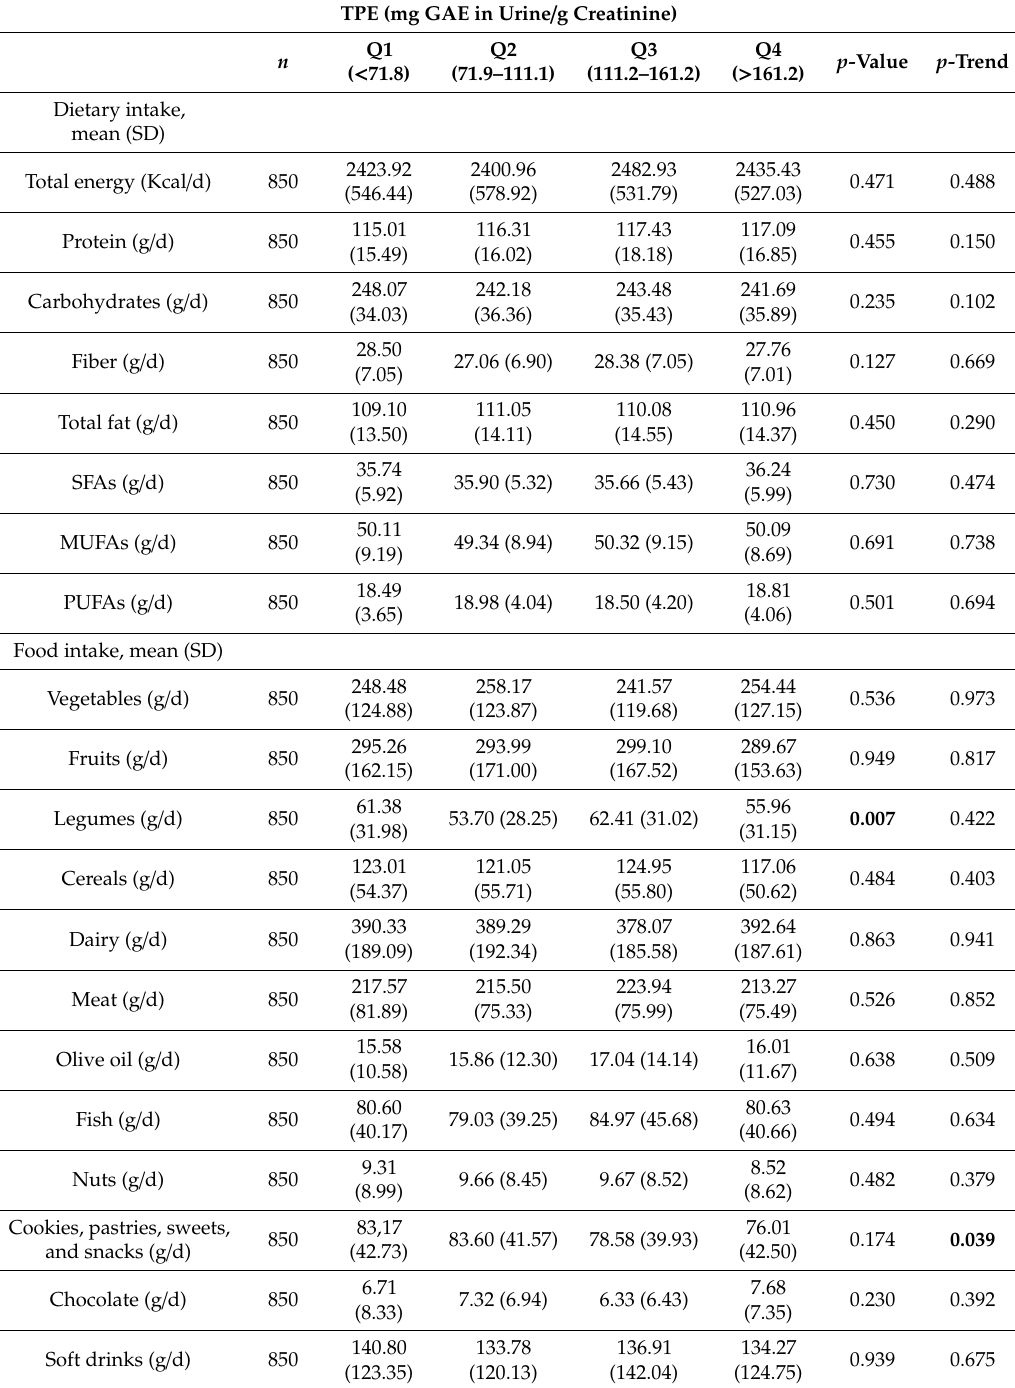
Table 3. Mean dietary nutrients and food intake, according to TPE quartiles (mg GAE in urine / g